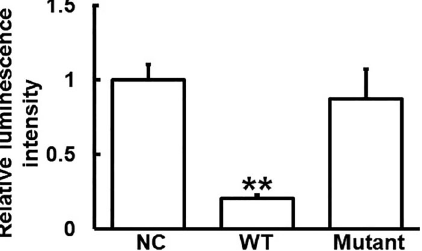
Figure 5. Identi fi cation of interaction between miR-17 and plasminogen activator inhibitor-1 (PAI-1) mRNA using dual luciferase reporter assay. Data are reported as means ± SD. **P o 0.01 wild type (WT) compared with negative control (NC) (ANOVA).